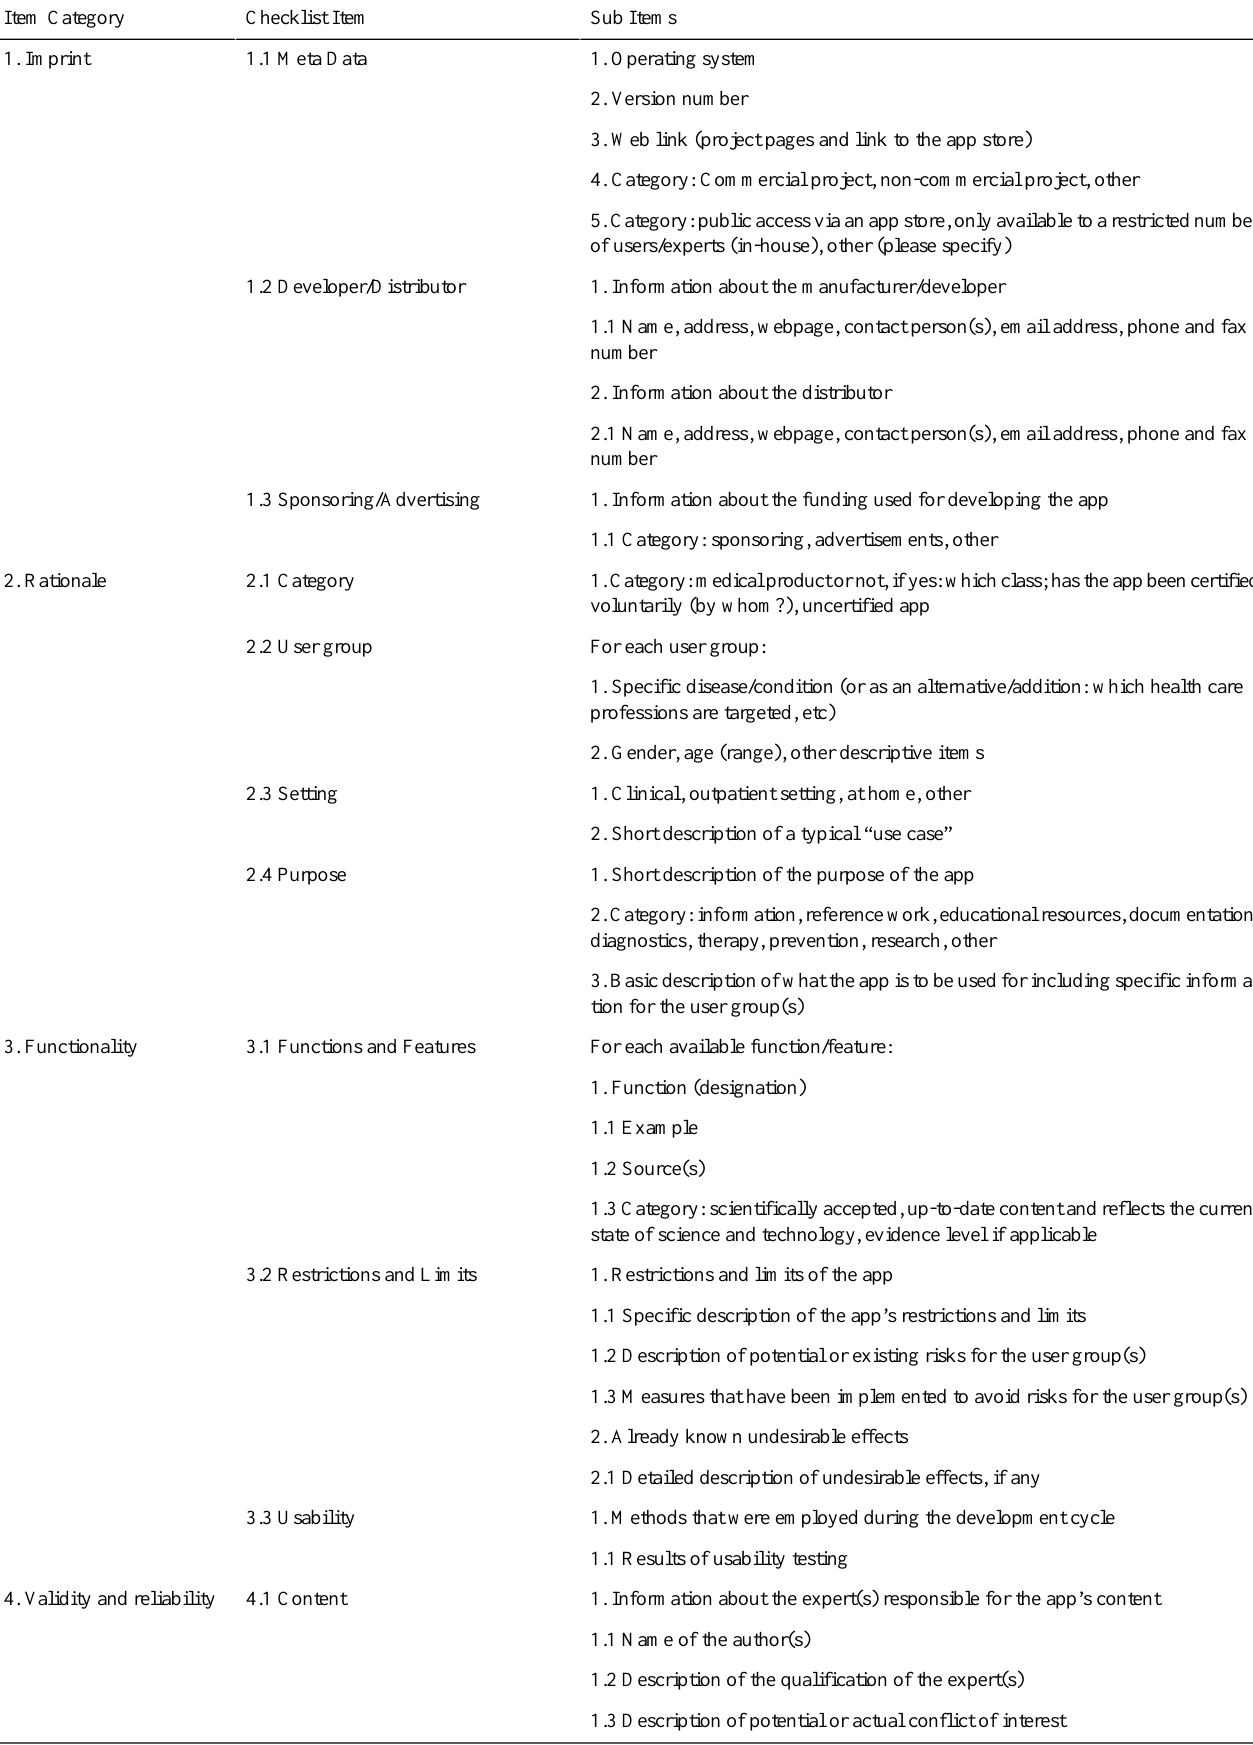
Sub ItemsChecklist ItemItem